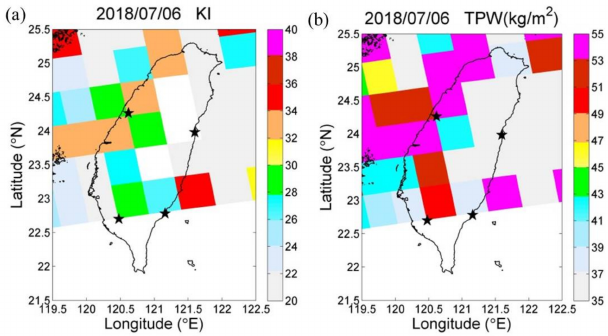
Figure 6. AIRS retrieval on 6 July 2018. ( a ) KI and ( b ) TPW distribution